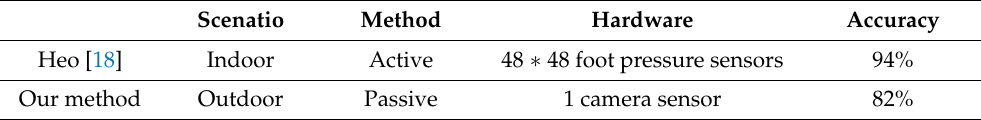
Table 2. Comparison of Heo [19] to our method.